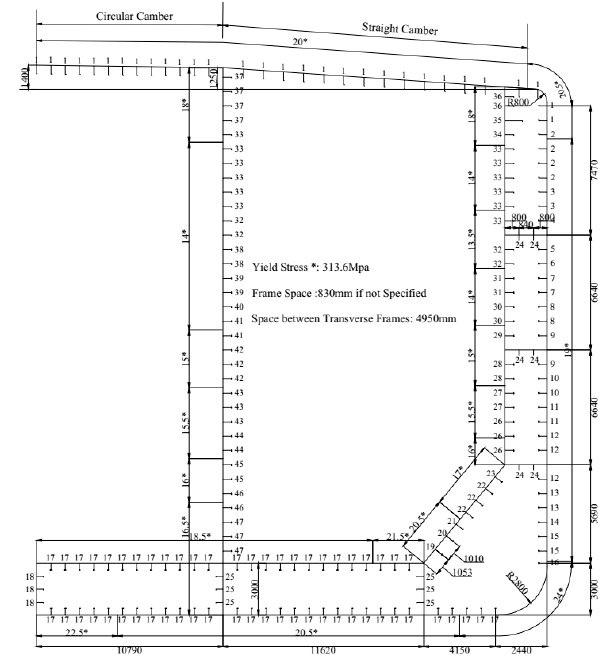
Figure 6. The cross-section of the double hull Very Large Crude Container (VLCC) (data were from [25]. Table 2. The stiffeners and dimensions of the double hull VLCC [25].